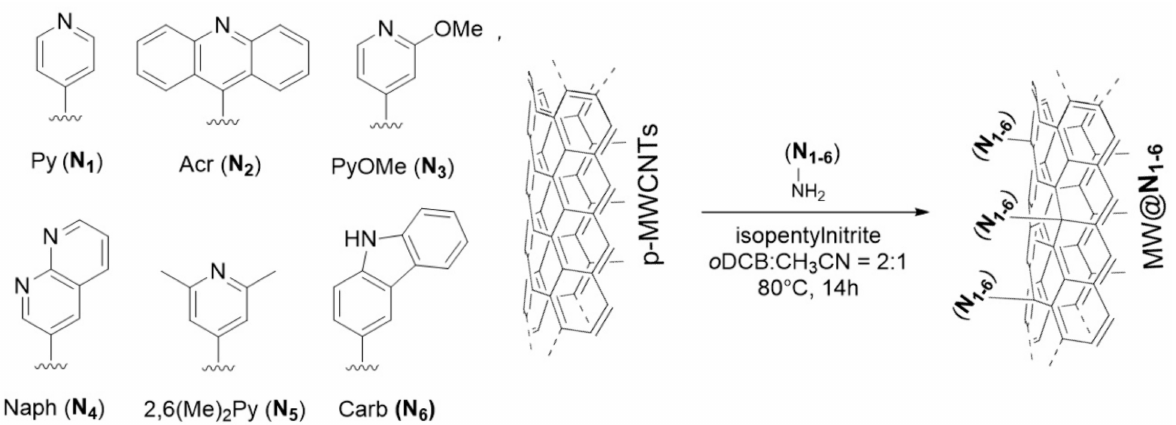
Figure 1. Exohedrally N-decorated MWCNTs (MW@N1–6) as metal free-catalysts for the CO 2 reduction reaction. Adapted from ref